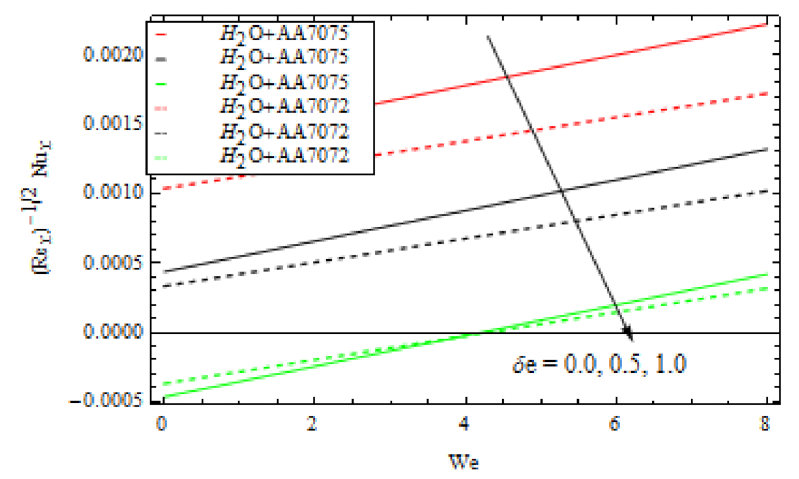
Figure 16. Various values of β versus We for skin friction.